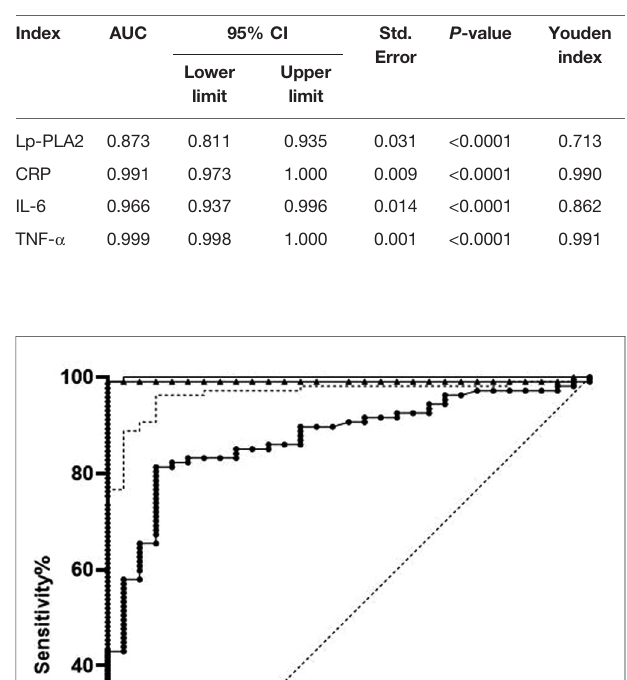
TABLE 3 | Predictive value of serum in fl ammatory factors in pregnant women with HDP.